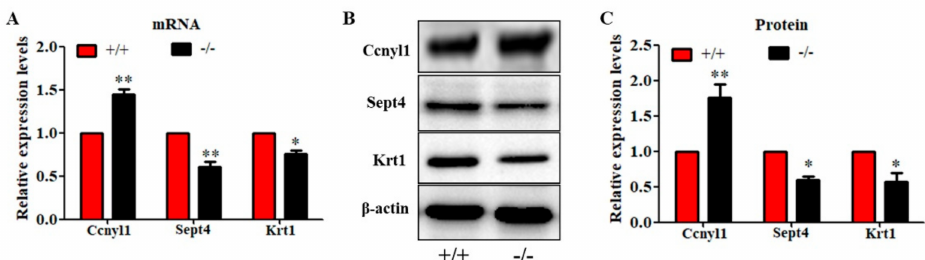
Figure 6. Genetic loss of calcium-binding protein spermatid-associated 1 (Cabs1) altered the expres- sion levels of cytoskeleton-related proteins in sperm. ( A ) mRNA, ( B , C ) protein expression levels of cyclin Y-like 1 ( Ccnyl1 ), septin 4 ( Sept4 ), and Krt1 in WT and KO mice. Total RNA was isolated from sperm using a RNAiso Plus kit, and qPCR was performed to detect mRNA expression levels. β -actin gene expression was used as a loading control. Equal amounts of total protein extracted from sperm of Cabs1 − / − and wild-type mice were subjected to SDS-PAGE and immunoblotting with antibodies directed against Ccnyl1, Sept4, and Krt1 and β -actin. ( B ) Blots are representative of three independent experiments, and the combined data are presented in histograms ( C ). Data in bar graphs are presented as mean ± SE. * p < 0.05 and ** p < 0.01 versus WT.